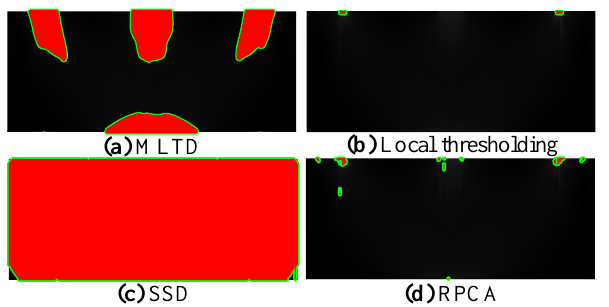
Figure 11. The detection result of the foreground cluster regions and sparse stress concentrations based on the HTD, Local thresholding, RPCA, and